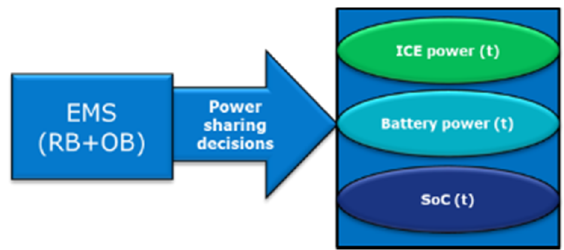
Figure 5. Power sharing based on the rule-based (RB) and optimization-based (OB) strategy.